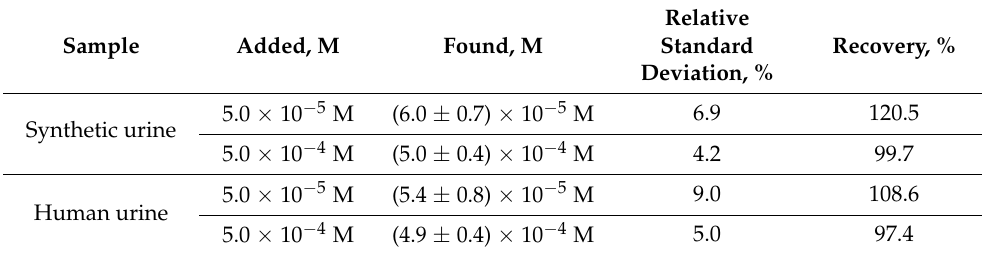
Table 3. Determination of salicylhydroxamic acid in spiked urine samples using SiFe10 xerogel ( n = 3, p =